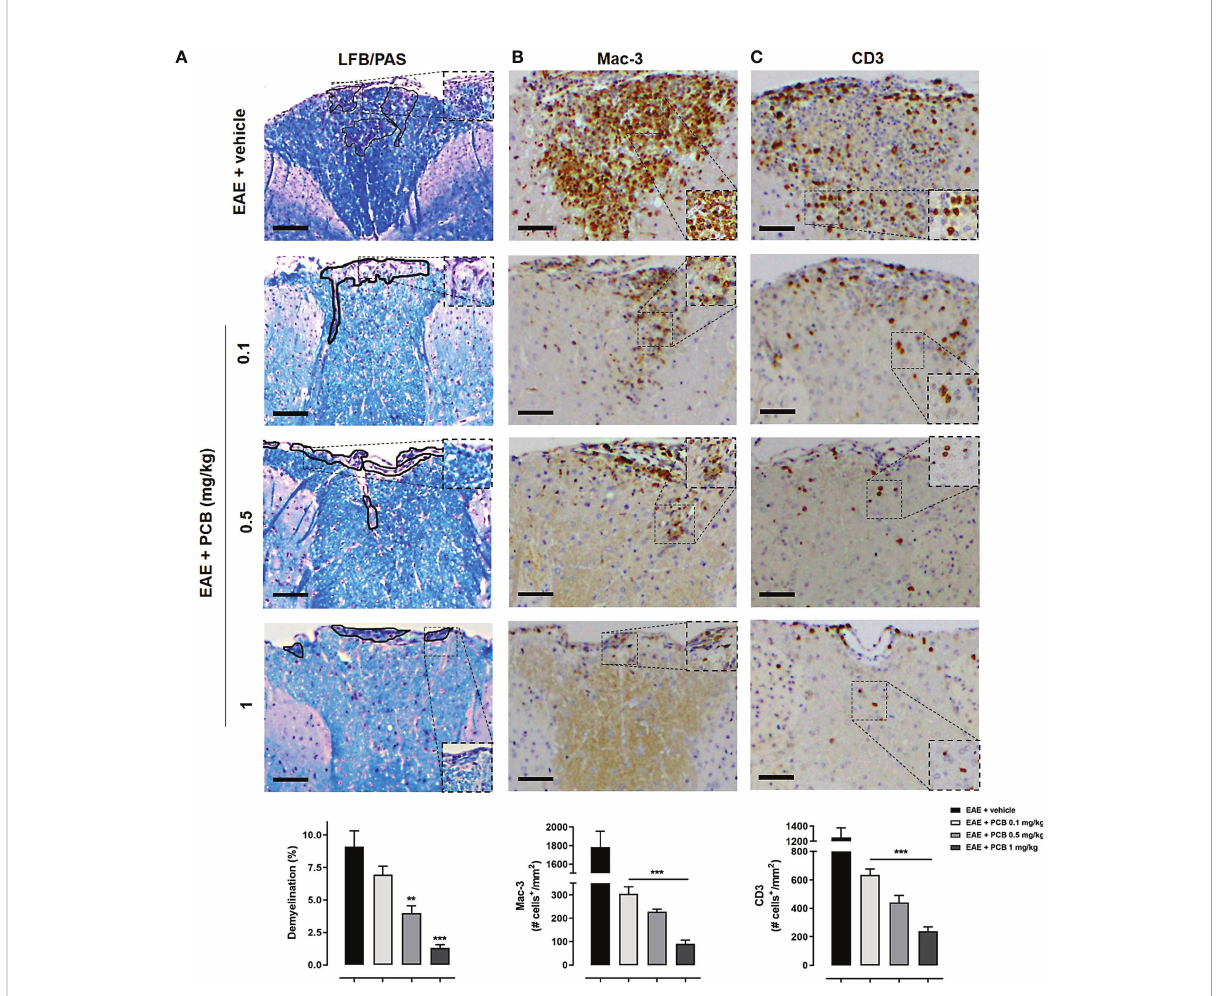
FIGURE 4 Histological and immunohistochemical assessment of the PCB effects on myelination and in fl ammation markers in spinal cords of EAE mice. The representative cross-sectional images and the respective morphometric evaluation per variable are shown in each panel. (A) Demyelination (LFB/PAS). (B) Macrophages/activated microglia (Mac-3). (C) T cells (CD3). MOG 35 – 55 immunized mice received a daily i.p. injection of PBS (vehicle) or PCB at 0.1, 0.5 or 1 mg/kg, from day 0 until day 26 post-immunization. The areas marked with black pencil indicate demyelination. The percentage of demyelination and the cell densities (number of positive marked cells per mm 2 ) were calculated by dividing with total area of the white matter in transversal sections. Data are expressed as mean ± SEM (n=4-7 per group). The asterisks indicate statistically signi fi cant differences vs. EAE + vehicle group (**p<0.01, ***p<0.001, Kruskal-Wallis + Dunn ’ s tests for LFB/PAS and Mac-3, ANOVA + Newman-Keuls tests for CD3). Bar: 50 m